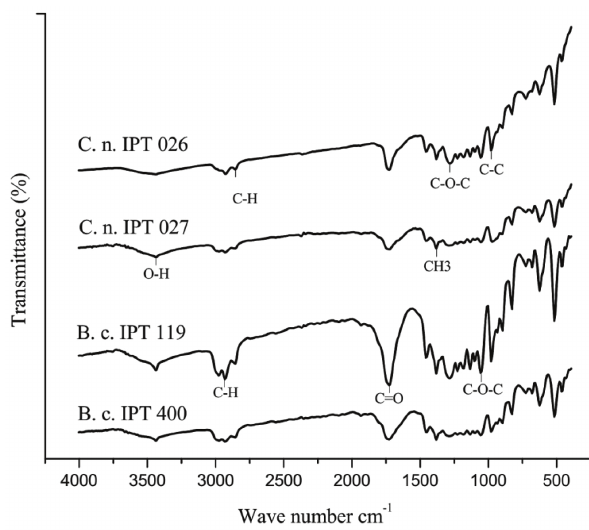
Fig. 1 – FTIR spectra of PHA produced by C. necator and B. cepacia strains in submerged cultivation with crude palm oil